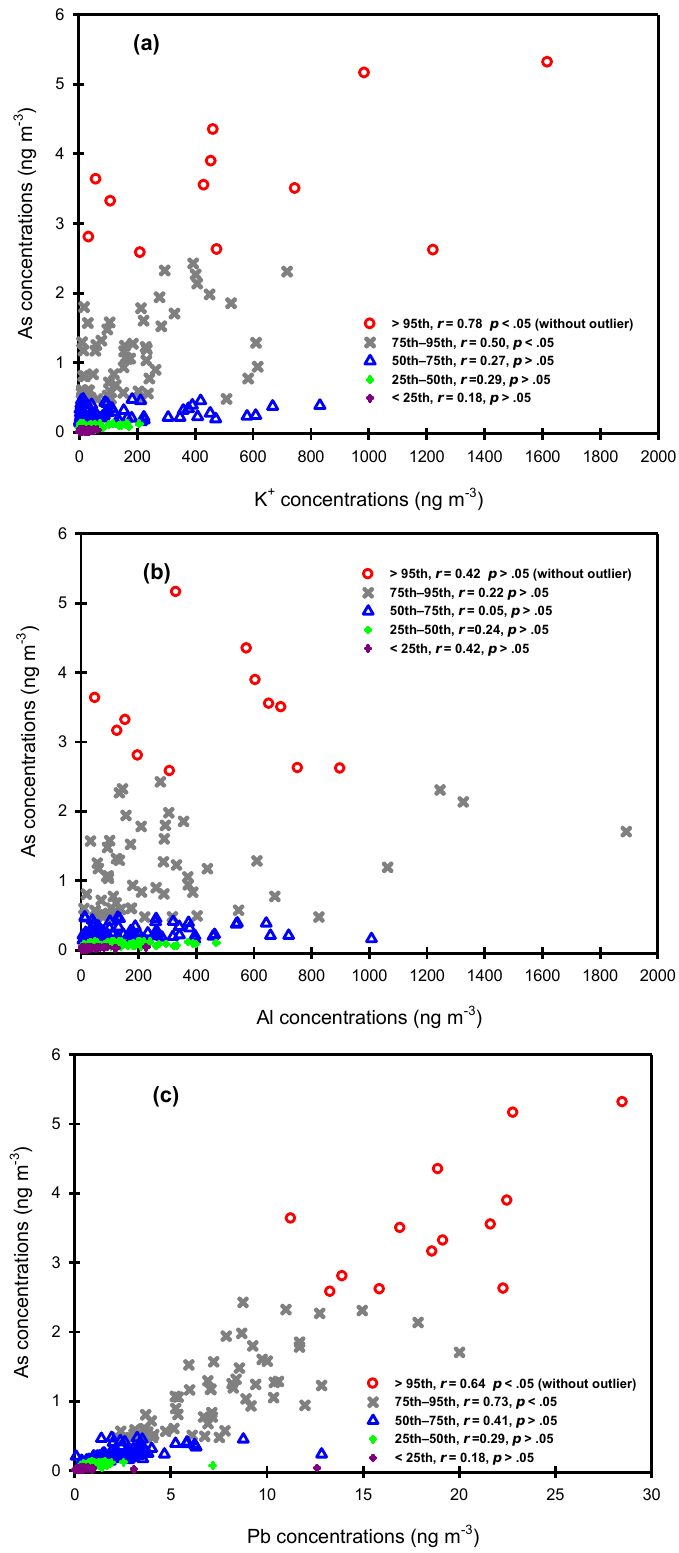
Figure 5. Scattered plots of As against (a) K + , (b) Al, and (c) Pb in different As concentration bins observed at Mount Hehuan.